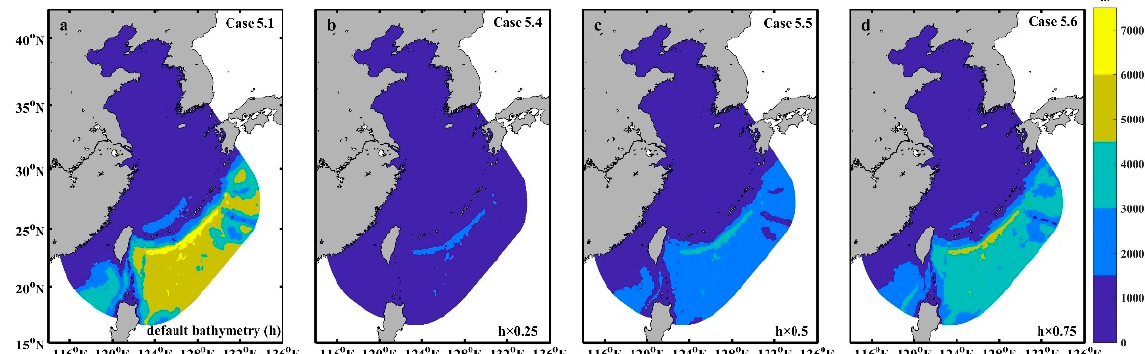
Figure 19. Bathymetry in different cases: ( a ) default bathymetry, ( b ) original depth × 0.25, ( c) original depth × 0.5, and ( d ) original depth × 0.75.